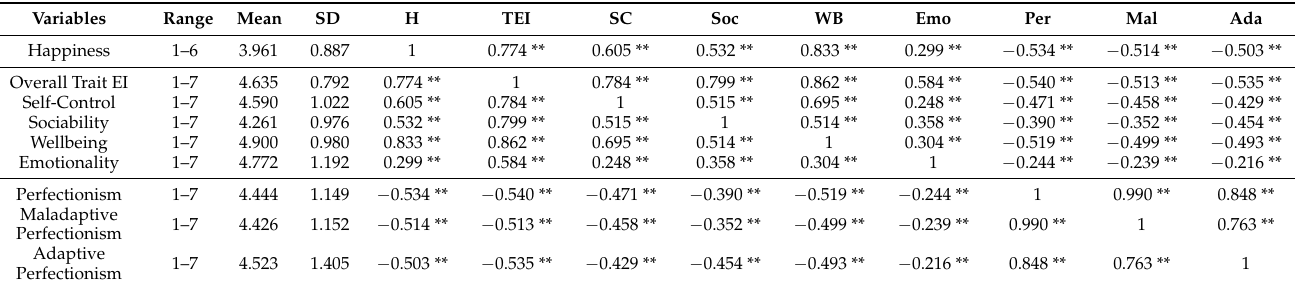
Table 1. Demographic and intercorrelation between variables.